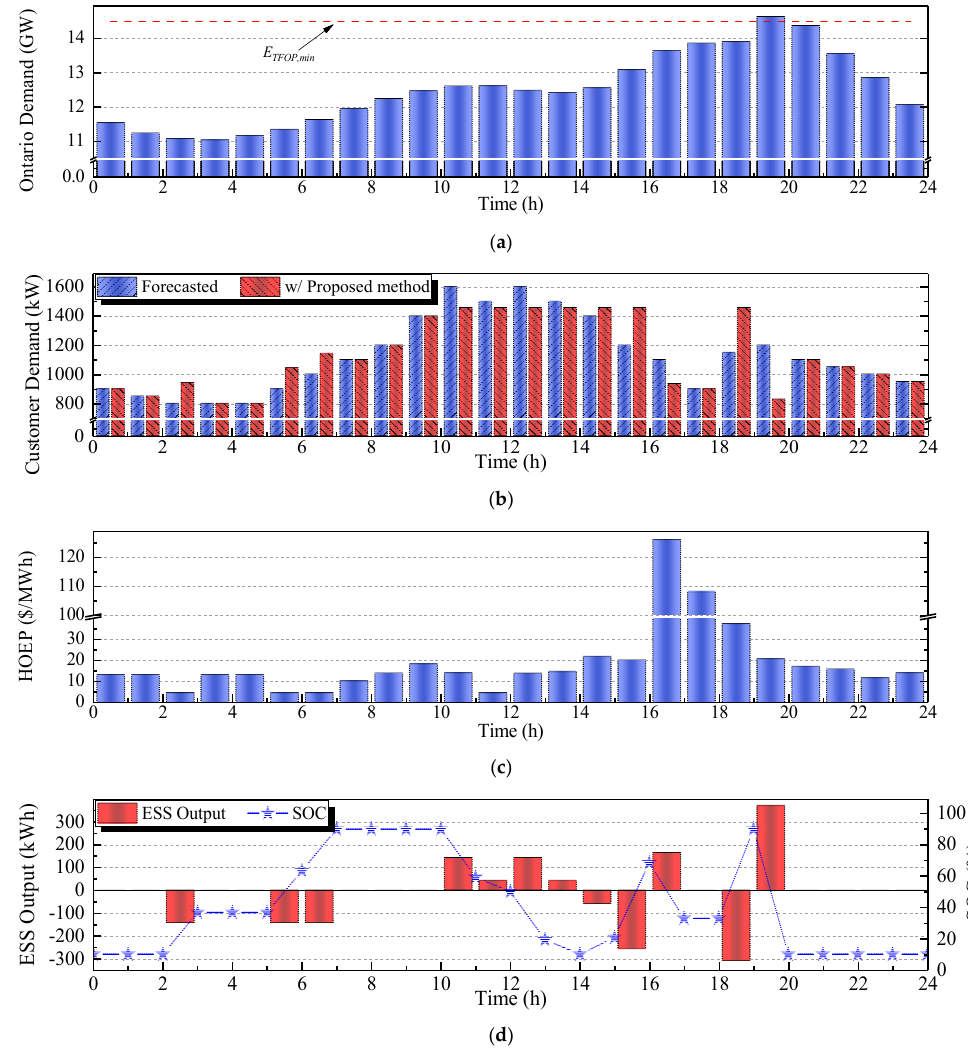
Figure 6. Results of the case study with the proposed method: ( a ) Forecasted Ontario demand; ( b ) Customer demand; ( c ) Forecasted HOEP; ( d ) Scheduled output and state-of-charge (SOC) of the energy storage system